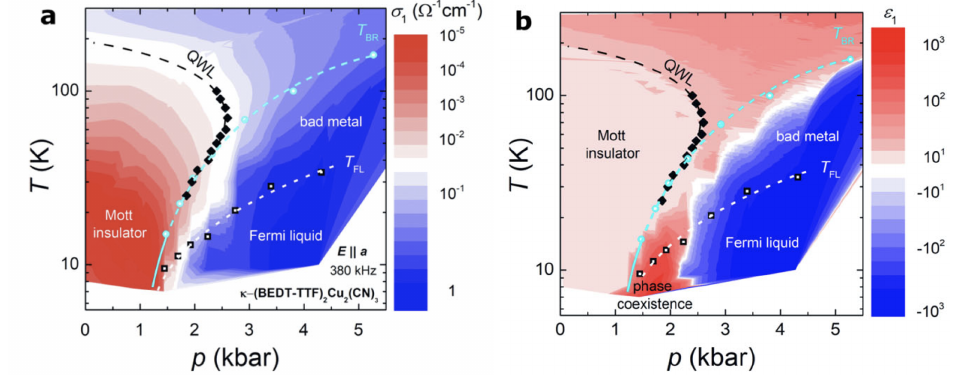
Figure 6. Transport behavior vs. dielectric response across the phase diagram of κ -Cu 2 (CN) 3 [20]. ( a ) DC transport shows only very gradual change across the BR line (resistivity maxima), and cannot one see any clear indication of the phase coexistence region. ( b ) In dramatic contrast, the low- frequency dielectric function (cid:101) 1 assumes small positive values in the Mott insulator (pale pink), and large negative values in the quasiparticle regime (deep blue); we clearly see the boundaries of these regimes tracing the QWL and the BR line (following T max ), as observed in transport. Remarkably, “resilient” quasiparticles [47] persist past the Fermi Liquid line, at T FL < T < T BR = T max , where bad metal behavior [48] (metallic transport above the Mott-Ioffe-Regel [49] limit is observed). At low temperature, the Mott point is buried below the phase coexistence dome, which is vividly visualized through colossal dielectric response ( (cid:101) 1 ∼ 10 3 –10 4